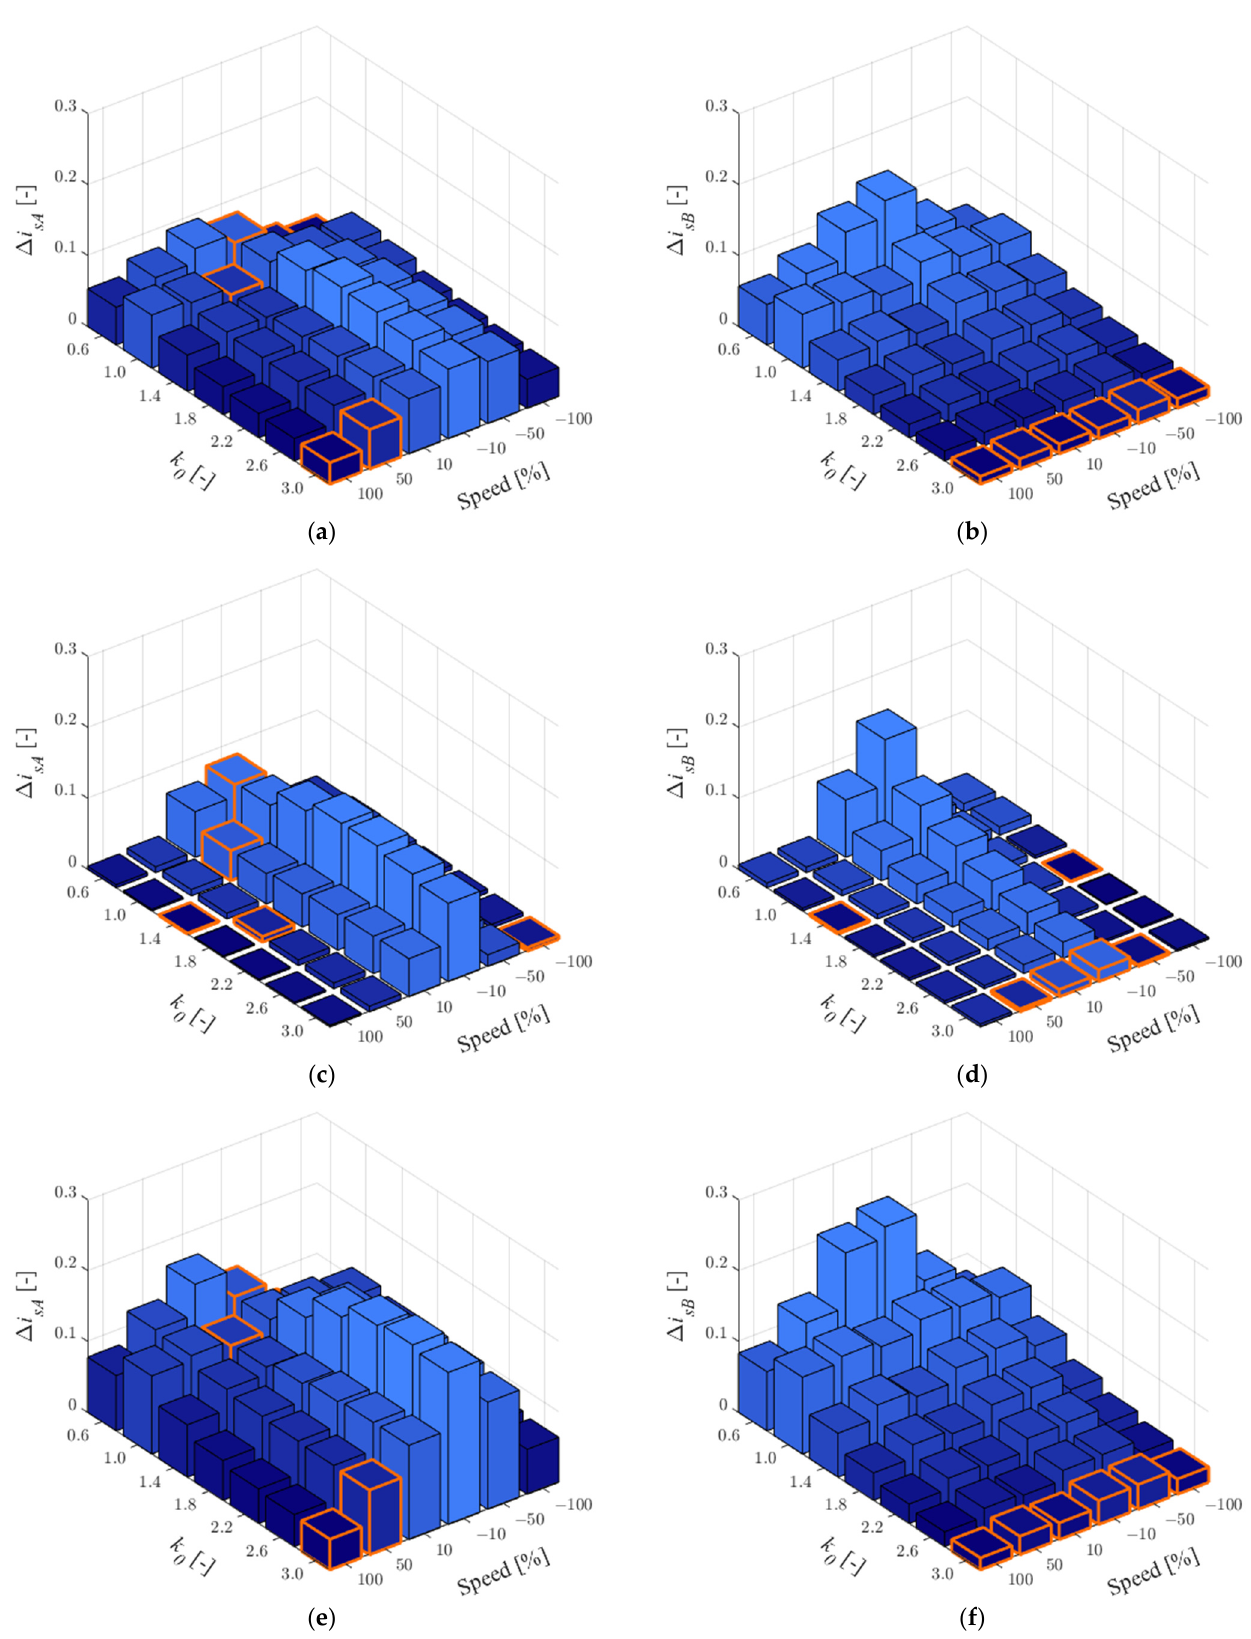
Figure 3. RMSE values for stator currents in phase A ( a , c , e ) and B ( b , d , f ) for r rIM = 1.5 r